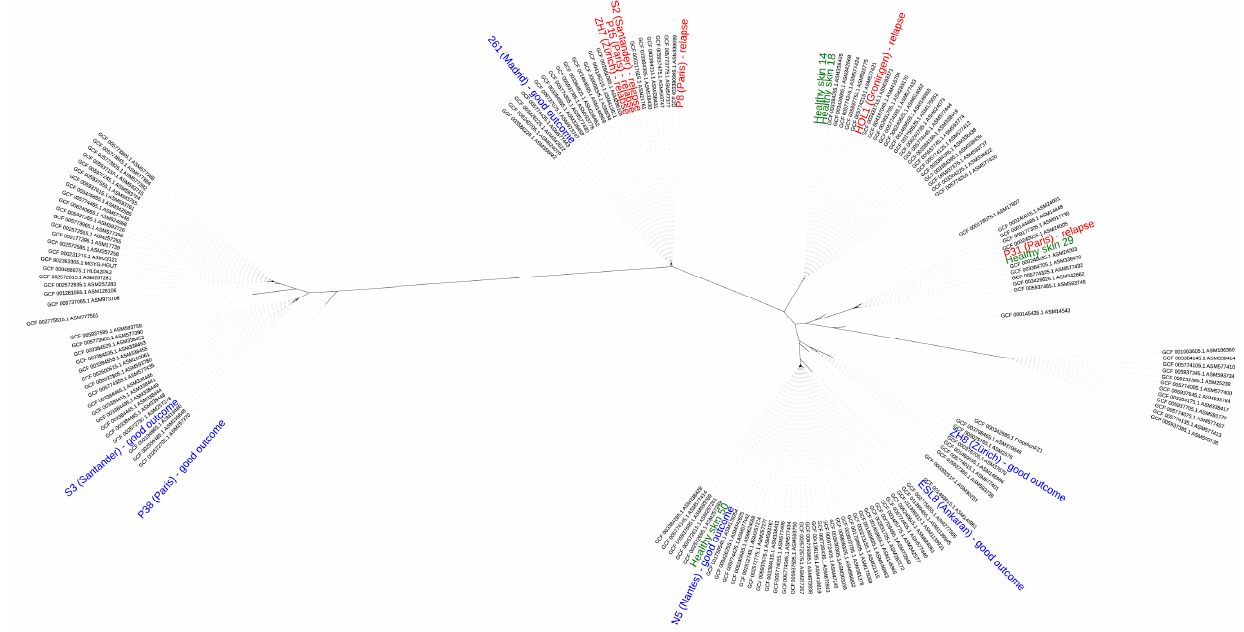
Figure 1. Phylogenomic comparison of C. acnes strains. The phylogeny was reconstructed from a core genome alignment and the comparison of high-quality SNPs. Strains isolated from healthy skin are labeled in green, strains from PJIs with a good outcome are in blue, and those from treatment failure (infection relapse) are in red. Labeled in black are genome-sequenced strains taken from GenBank (only genomes with high-quality assemblies (N 50 > 500 kb); status March 2021). The geographical origin of the strains used in this study is indicated in brackets. The sixteen strains belong to different clades, indicating that there is not a clear separation according to their disease association, disease condition and geographical